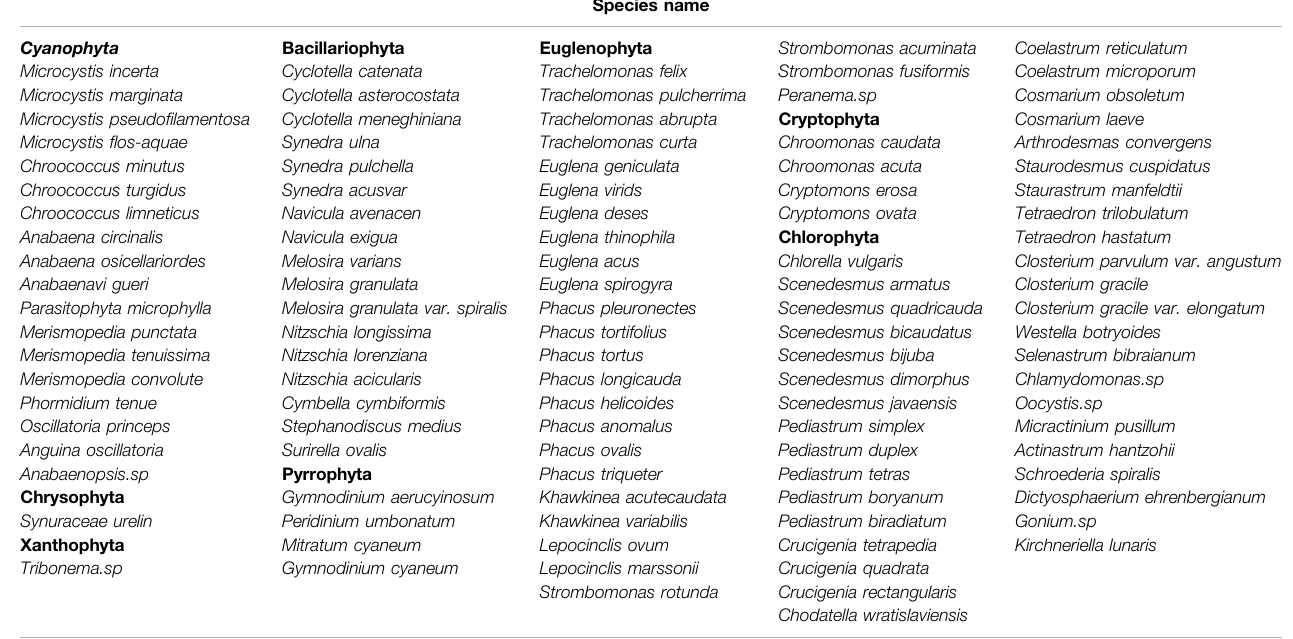
TABLE 3 | Phytoplankton species composition in a typical tilapia